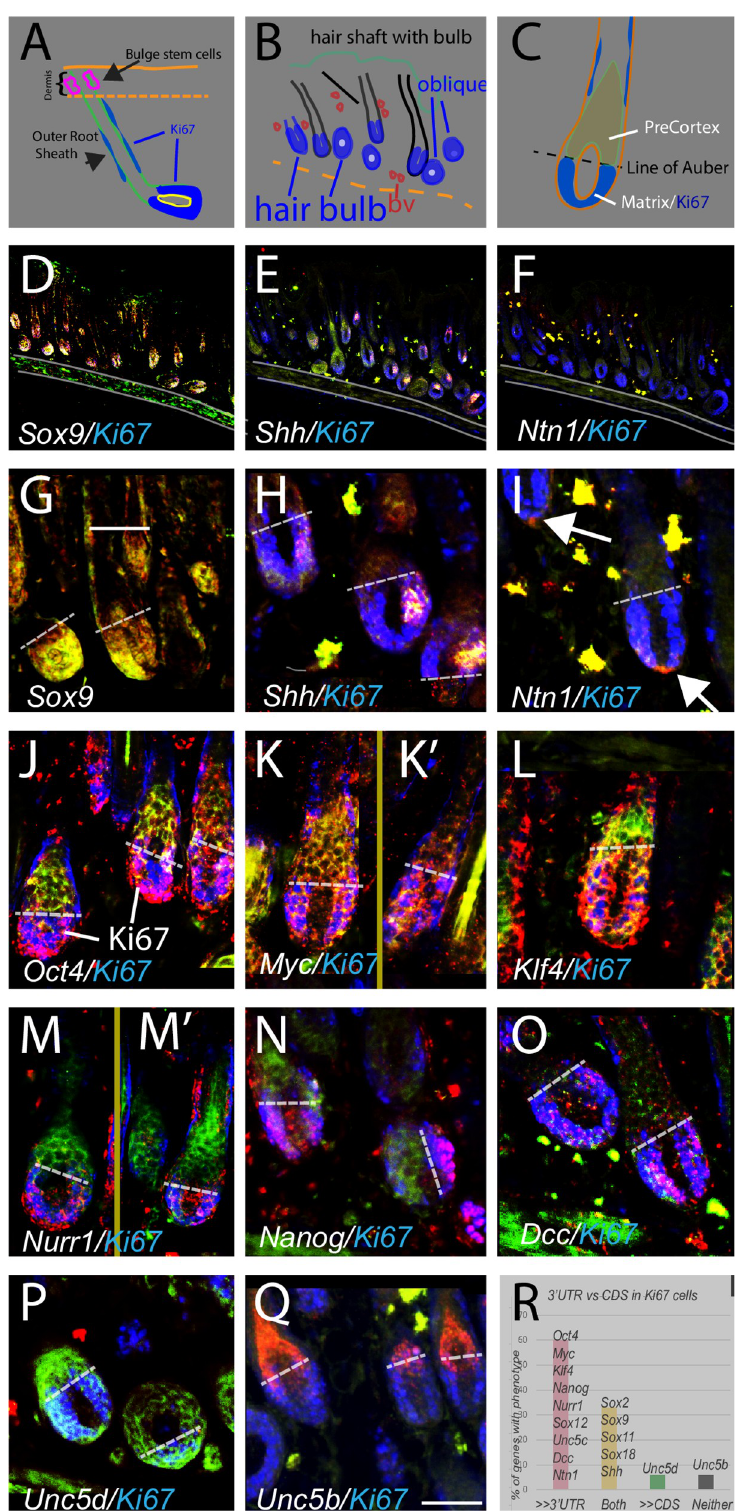
Fig 3. The 3’UTR/CDS ratio for PpG and other genes changes abruptly at the boundary between the Ki67 + proliferative zone and non-proliferative zone. (A) Key anatomy of skin hair follicle; stem cells located dorsally within dermis, outer root sheet (ORS) at the perimeter of the follicle, proliferating cells (Ki67+) in deep hair bulb and